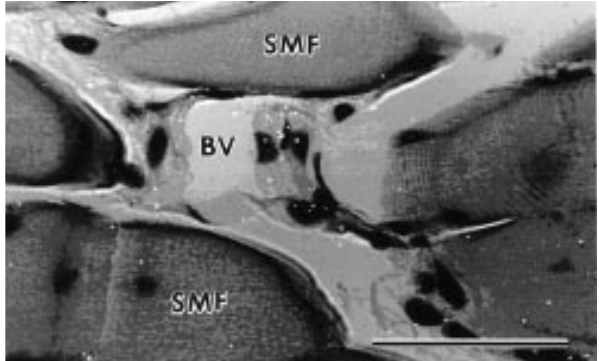
Figure 2 - Overlay image of differential interference contrast (DIC) and confocal LSM images of microradioautographs of mouse skeletal muscle 3 min after 125 I-insulin injection. The number of silver grains on the wall of blood vessels (BV) are higher than that found in skeletal muscle fibers (SMF). Bar = 50